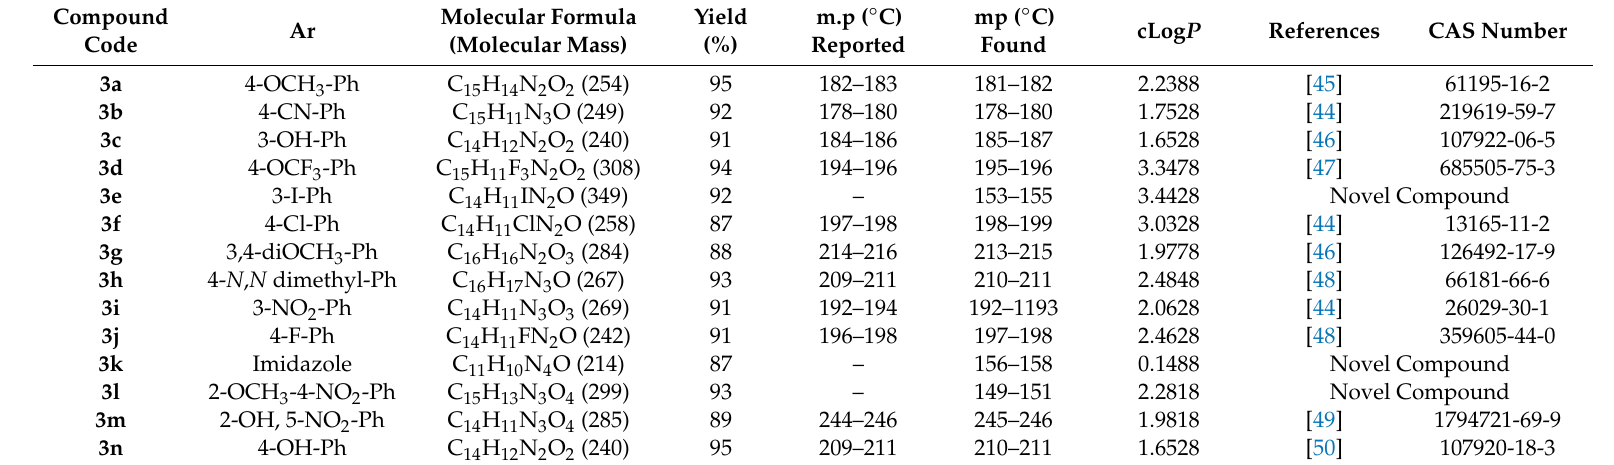
Table 1. Physicochemical characteristics of 2-(substituted phenyl)-2,3-dihydroquinazolin-4(1 H )-ones ( 3a–n